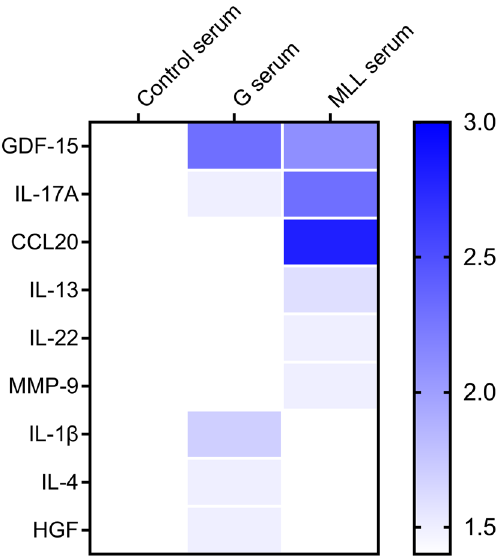
Figure 6. Cytokine protein profile in serum. Relative cytokine concentrations in serum from tumor-bearing animals (G serum and MLL serum) compared to serum from tumor-free controls (control serum, set as 1). The heatmap illustrates fold-change relative to levels in control-serum, white color indicates no changes compared to controls and blue color indicates higher levels (≥